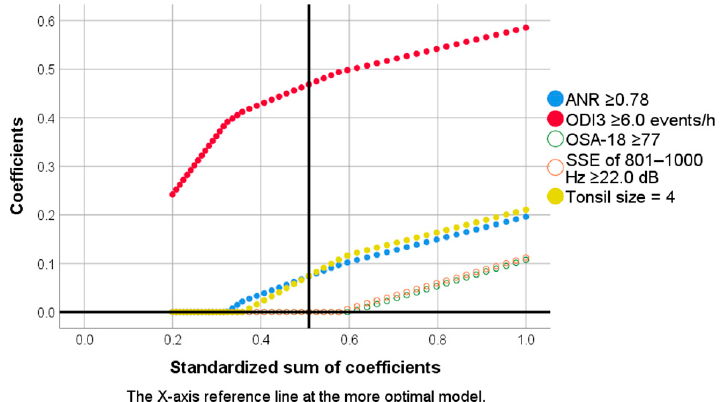
Figure 2. Logistic least absolute shrinkage and selection operator paths for severe pediatric obstructive sleep apnea (OSA). Five variables, including 3% oxygen desaturation index (ODI3) ≥ 6.0 events/h, adenoid/nasopharynx ratio (ANR) ≥ 0.78, tonsil size—4, snoring sound energy (SSE) of 801–1000 Hz ≥ 22.0 dB, and OSA-18 ≥ 77, were analyzed using the multivariate categorical regression models. The X-axis reference line indicates the combined model (three variables).